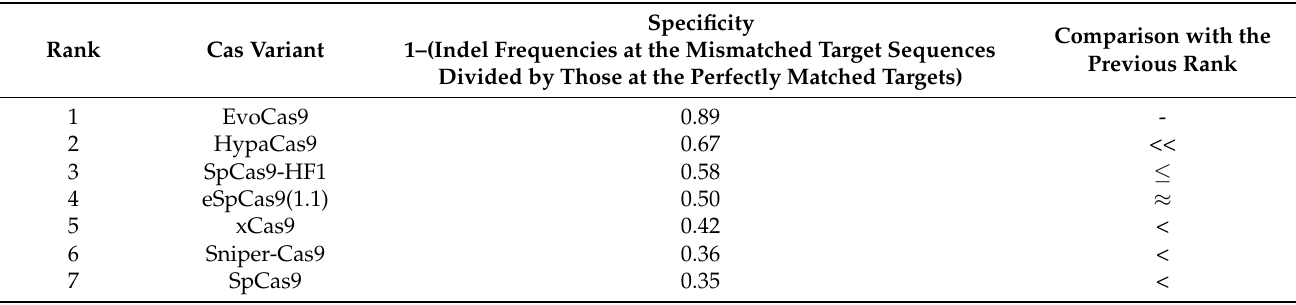
Table 7. Ranking of high-fidelity Cas9 variants according to specificity. Adapted from Kim et al. (2020) [132]. Specificity Comparison with the Rank Cas Variant 1–(Indel Frequencies at the Mismatched Target Sequences Previous Divided by Those at the Perfectly Matched Targets)